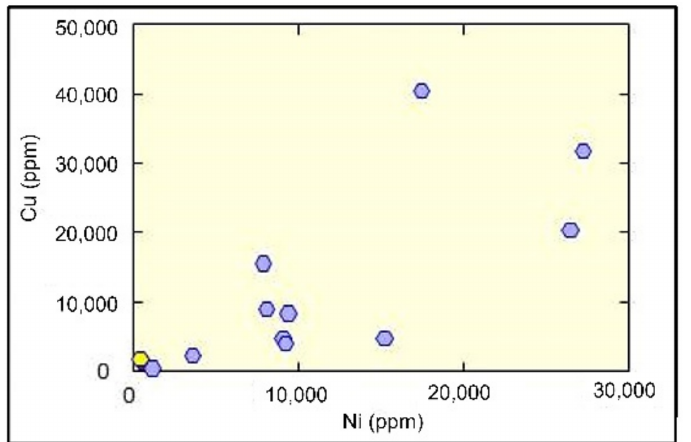
Figure 7. Ni vs. Cu variation diagram for samples from hole VB95-129; the anorthosite sample (5.06–5.15 m) is yellow, the gossan sample (3.4–3.48 m) is red and the plots under the yellow symbol, the remaining samples are